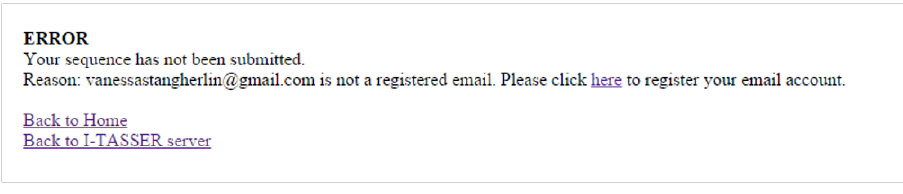
Figure 3. One of the heuristics violated: help users recognize, diagnose, and recover errors. The error message was displayed in a new browser window, far from where it occurred